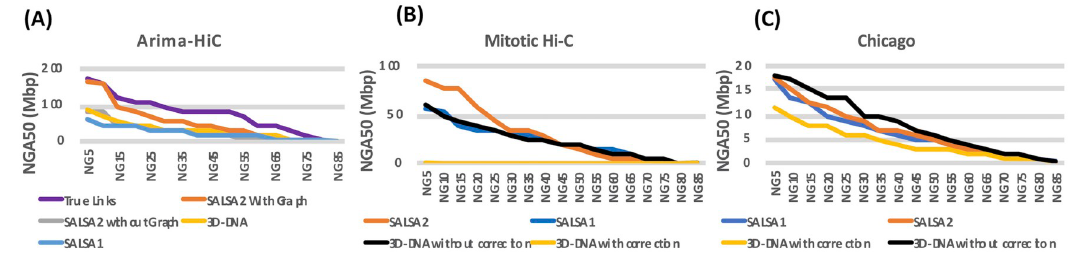
Fig 7. Contiguity plot for scaffolds generated with (A) standard Arima-HiC data (B) mitotic Hi-C data and (C) Chicago data. The X-axis denotes the NGAX statistic and the Y-axis denotes the corrected block length to reach the NGAX value. SALSA2 results were generated using the assembly graph, unless otherwise